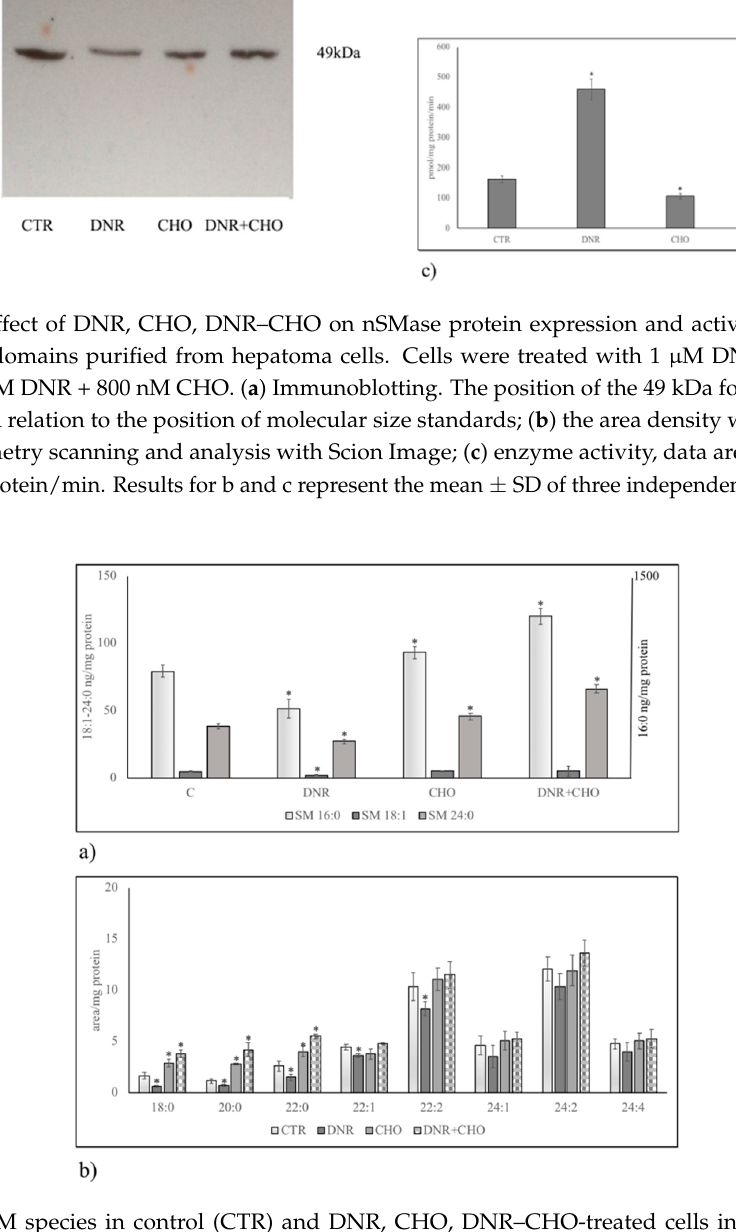
Figure 5. SM species in control (CTR) and DNR, CHO, DNR–CHO-treated cells in nuclear lipid microdomains purified from hepatoma cells. Cells were treated with 1 μ M DNR or 800 nM CHO or 1 μ M DNR + 800 nM CHO. ( a ) SM species studied by using 16:0 SM, 18:1 SM, and 24:0 SM external calibrators. Data are expressed as nmol/mg protein and represent the mean ± SD of three separate experiments. Data of SM 16:0 are referred to on the right ordinate; ( b ) SM species studied by evaluating the areas of all the peaks identified on the basis of their molecular weight. Data are expressed as area/mg protein and represent the mean ± SD of three separate experiments. * p < 0.05.